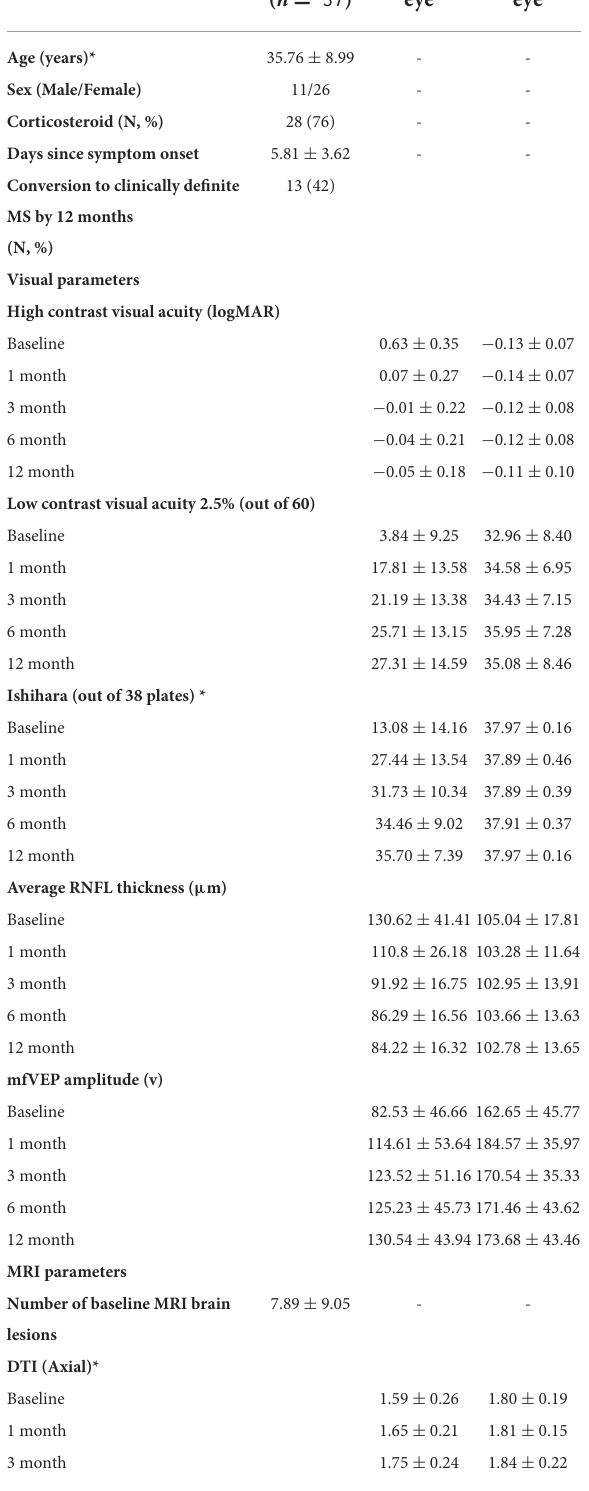
TABLE 1 Demographic and baseline clinical visual measures of ON patients.